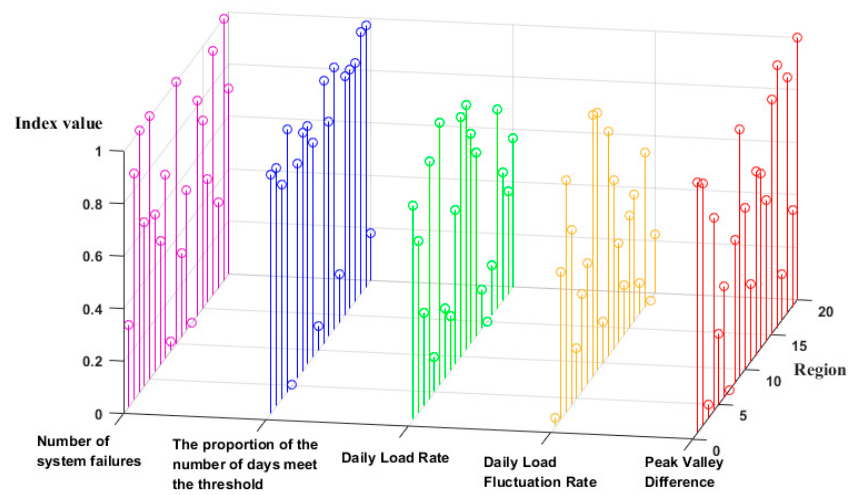
Figure 9. Value of individuality indexes of WG in 20 regions.